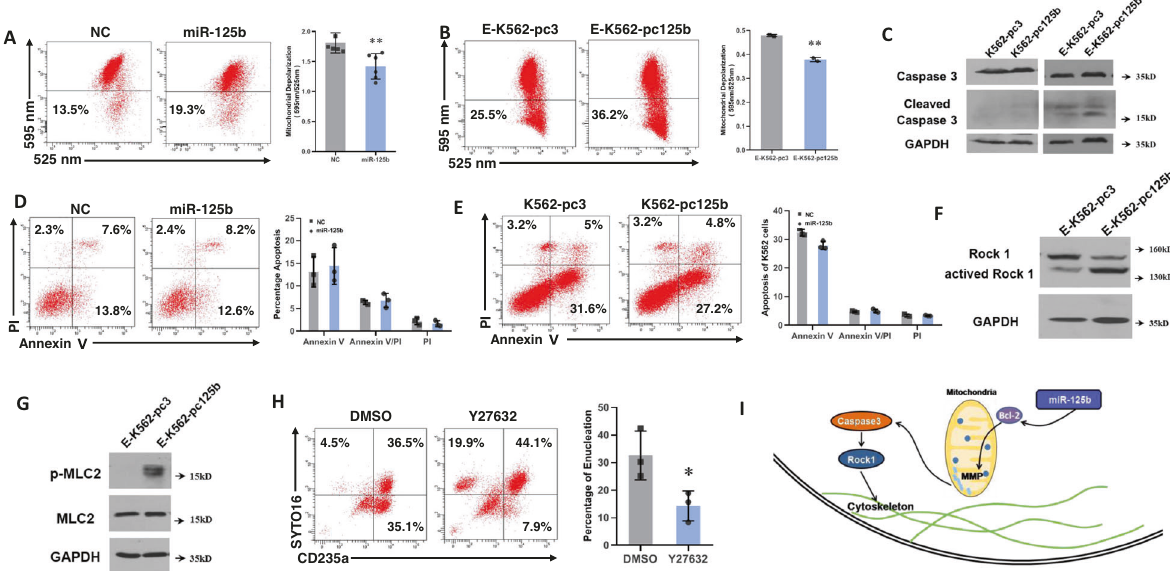
Fig. 7 The miR-125b-5p-Bcl-2-ROCK signaling pathway is involved in erythroblast enucleation. Mitochondrial depolarization was determined by JC-1 staining and the ratio of the fl uorescence intensity at 595nm/525nm in erythropoiesis of hCB-MNC-derived erythroblasts ( A ) and K562 cells ( B ) Representative images of fl ow cytometry analysis and statistical analysis of JC-1 staining are presented in the left and right panels, respectively. Statistical analysis of data from independent experiments is presented as the mean ± SD (A, p = 0.0054 ( n = 6); and B, p = 0.0051 ( n = 3)). C Representative images of western blots show caspase-3 and cleaved caspase-3 levels in miR-125b-5p-overexpressing/control K562 erythroid cells before and after erythroid differentiation. Cleaved caspase-3 was increased in erythroid differentiated K562 cells (E-K562). miR- 125b-5p overexpression further enhanced cleaved caspase-3. D , E Representative images of fl ow cytometry assay (left panel) and statistical analysis (right panel) of apoptosis by Annexin-V/PI staining in hCB-MNC-derived erythroblasts ( D ) and erythroid K562 cells ( E ). Quantitative analysis of three independent experiments is shown as the mean ± SD. F Representative western blot images show ROCK-1 and active ROCK-1 levels in miR-125b-5p-overexpressing/control K562 cells after erythroid differentiation. G Representative western blot images show that the overexpression of miR-125b-5p in K562 erythroid cells improved phosphorylated MLC2 levels. H Flow cytometry analysis of primary erythroblast enucleation ef fi ciency (CD235a + SYTO 16 − %) after treatment with Y27632, a small molecule inhibitor of ROCK-1. Right panel, Statistical analysis of the enucleation rates of three independent experiments is expressed as the mean ± SD ( p = 0.0138). I Working model of miR-125b-5p in erythroblast enucleation. miR-125b-5p downregulates the expression of Bcl-2 followed by mitochondrial depolarization and the activation of caspase-3. serum for 30min. Next, the cells were incubated with tubulin antibodies overnight at 4°C. After three washes with phosphate-buffered saline (PBS), the cells were incubated with phalloidin together with the corresponding secondary antibody. Then, the cells were stained with DAPI for 2min. Finally, stained cells were visualized by confocal microscope (PE Ultra VIEW VoX).